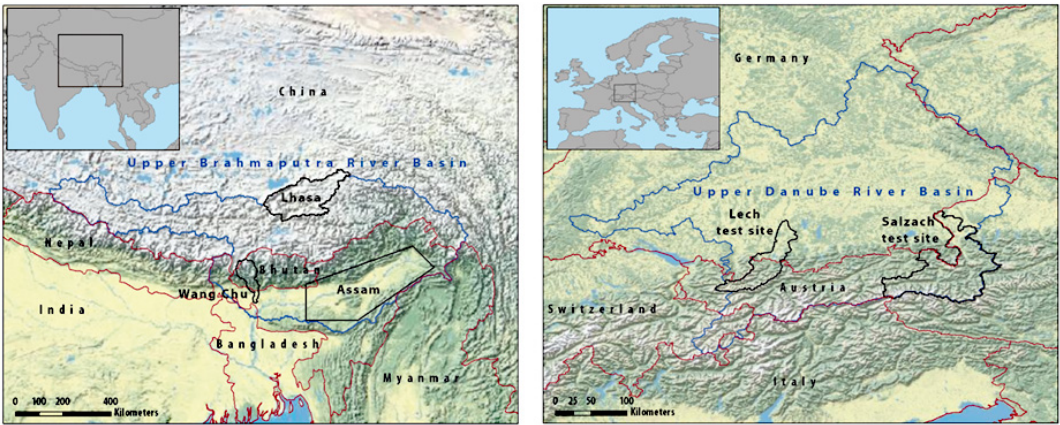
Figure 1. Outline location maps for key study sites within the BRAHMATWINN project.